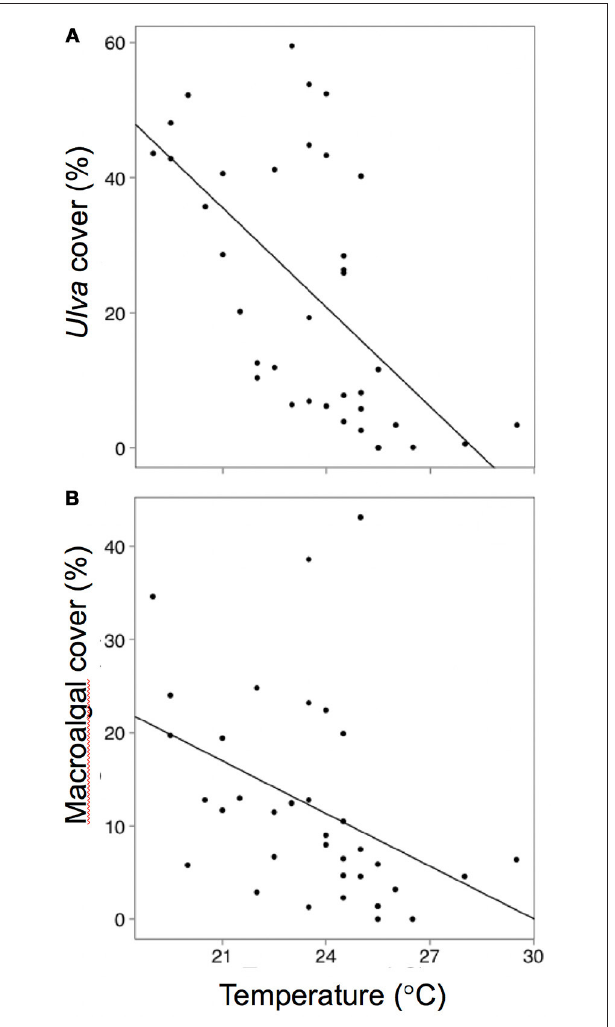
FIGURE 3 | Relationships between (A) ocean temperature and Ulva cover ( P < 0.0001, R 2 = 21.8), and (B) cover by all other macroalgae (not including Ulva : P = 0.01, R 2 = 14.4). Each point represents a single survey at a given site/time period.